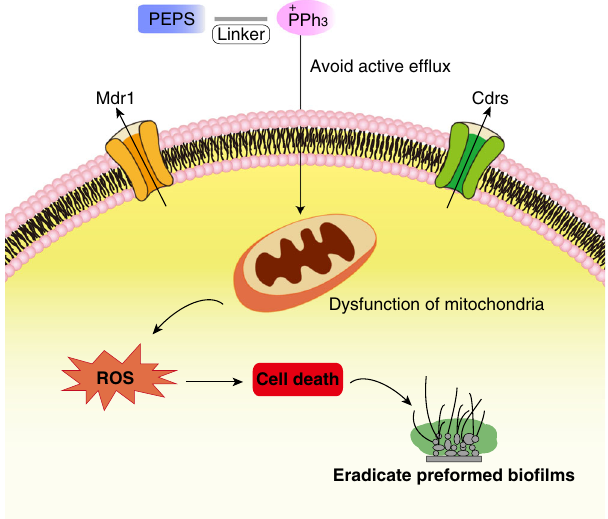
Fig. 6 The proposed model of antifungal applications of TPP + -conjugates. Cdr substrates with potential antifungal activities are chemically conjugated with TPP + . The TPP + -conjugates regain the ability to kill C. albicans wild- type or resistant strains and even can eradicate highly drug-resistant bio fi lms. The TPP + -conjugates bypass active expulsion by ef fl ux pumps and accumulate in the mitochondria to exert fungicidal activity by